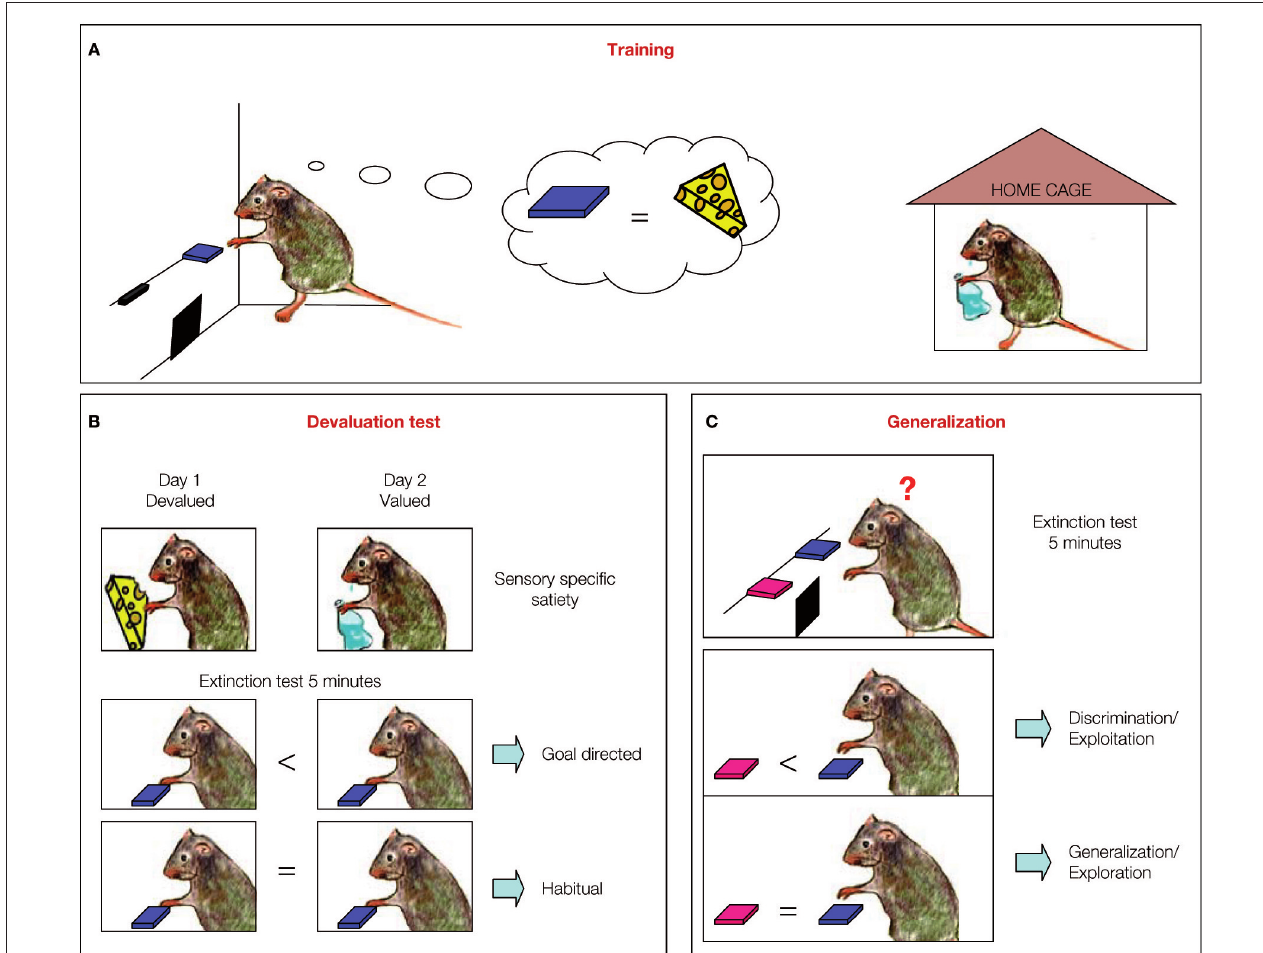
Figure 1 | Investigating goal-directed actions and habit formation in mice. (A) Mice were trained with two reinforcers. In the figure, the task is exemplified with one of the reinforcers, cheese, being delivered in the operant box contingent upon lever pressing, while the other reinforcer, sugar water, is being delivered freely to the mouse in the home cage. The types of reinforcers used in the figures are for illustrative purposes only. (B) Devaluation is performed in two days: Day 1, the mouse is given the reinforcer, cheese, previoulsy earned by lever pressing (devalued condition); Day 2, the mouse receives the reinforcer, sugar water, previously freely available in its home cage (valued condition). The order of the conditions is randomized. Immediately after each feeding